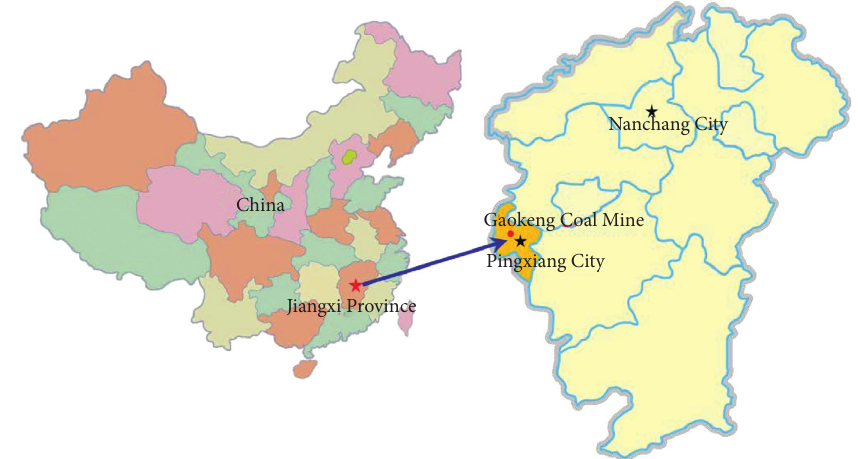
Figure 1: Geographical location of the Gaokeng Coal Mine.